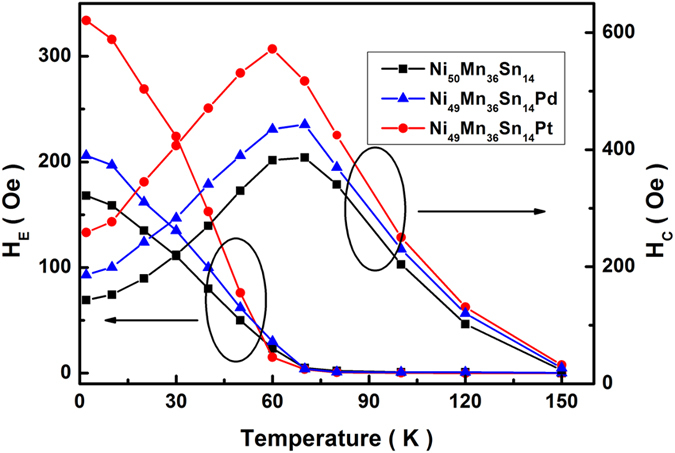
The temperature dependence of HE and HC for Ni49Mn36Sn14T (T = Ni, Pd, Pt) alloys after FC (HFC = 10 kOe) from 300 K.